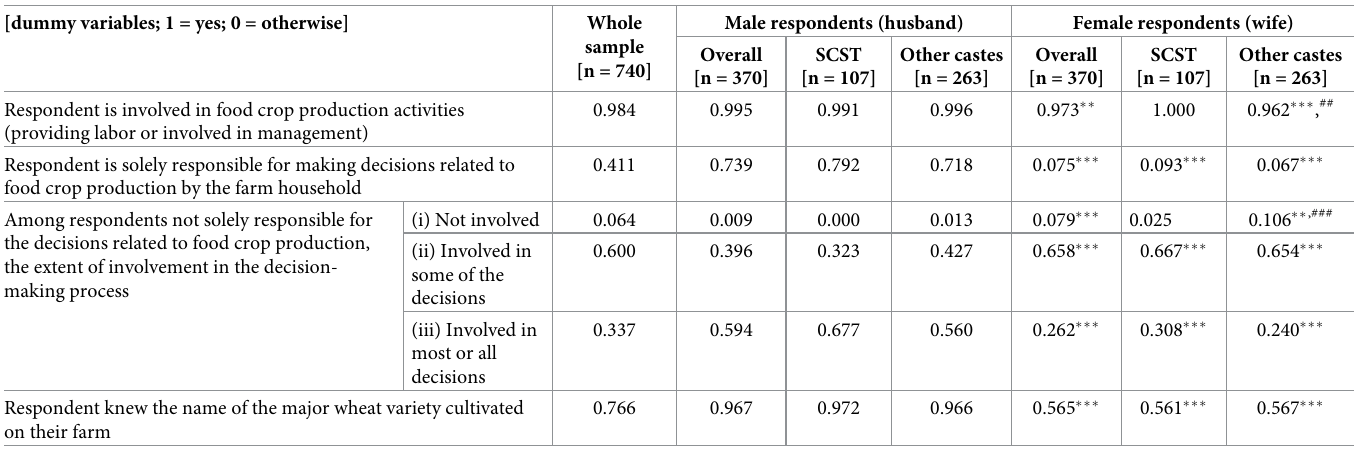
Table 3. Role of husbands and wives in wheat producing farm-households across the gender and caste groups. [dummy variables; 1 = yes; 0 = otherwise] Whole